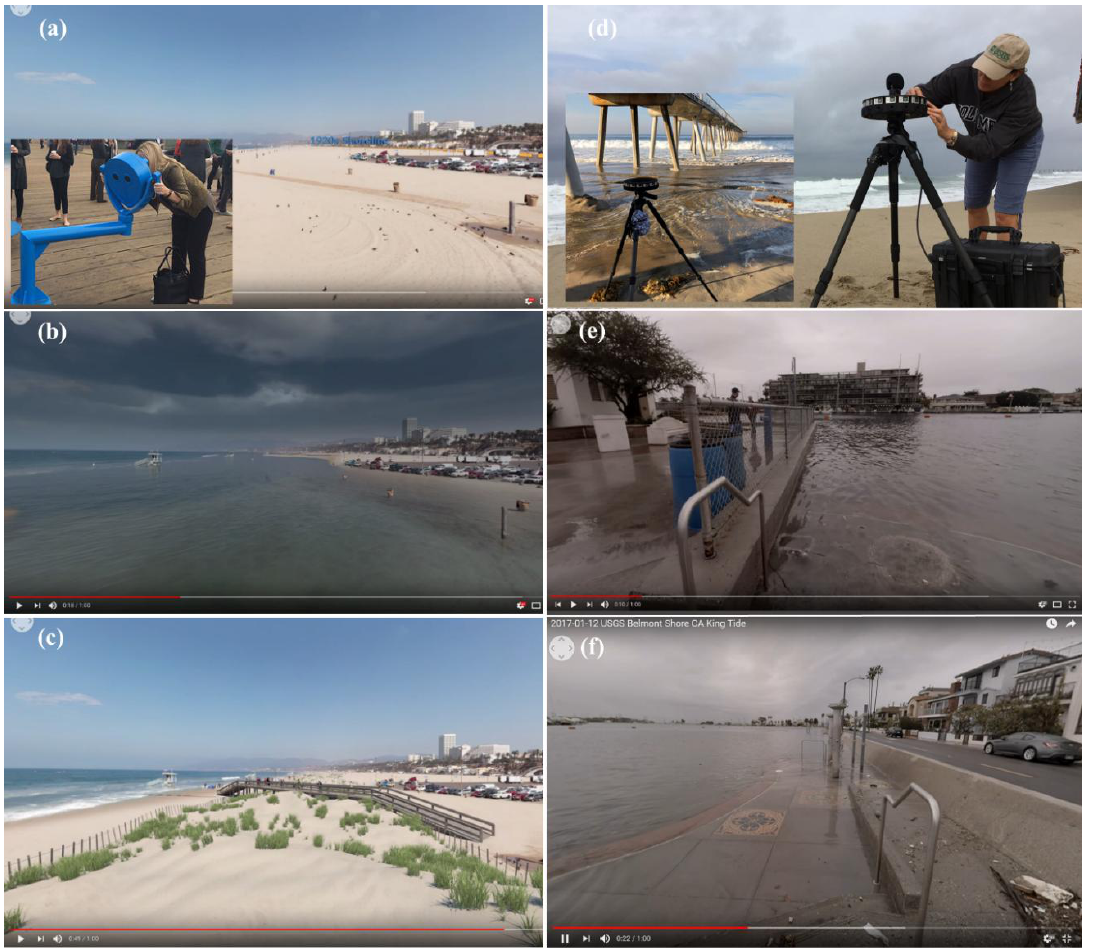
Figure 8. Images showing stills from virtual reality simulations of sea-level rise (SLR) potentials. ( a – c ) Example images (screen-grabs: mobileowl.co/samo) from the virtual reality (VR) viewer shown in ( a ). ( a ) Present day conditions and the 1920’s shoreline position at Santa Monica Beach in Los Angeles County, California (CA). Inset photo shows use of the viewfinder for observing and scanning the VR images; ( b ) VR image of CoSMoS-modeled shoreline position with a 2 m SLR; ( c ) VR image of a possible adaptation option employing vegetated dunes; ( d – f ) Example images (screen-grabs: https://www.youtube.com/watch?v=FQl93W469vI) from the 360-degree 3-D viewer and video. Videos of annual high tides are filmed to serve as proxies for future sea levels under everyday normal tide conditions; the videos are viewed in 3-D by users using any VR headset. Inset photos in ( d ) show the 16 GoPro™ camera system used to capture the 360-degree view.